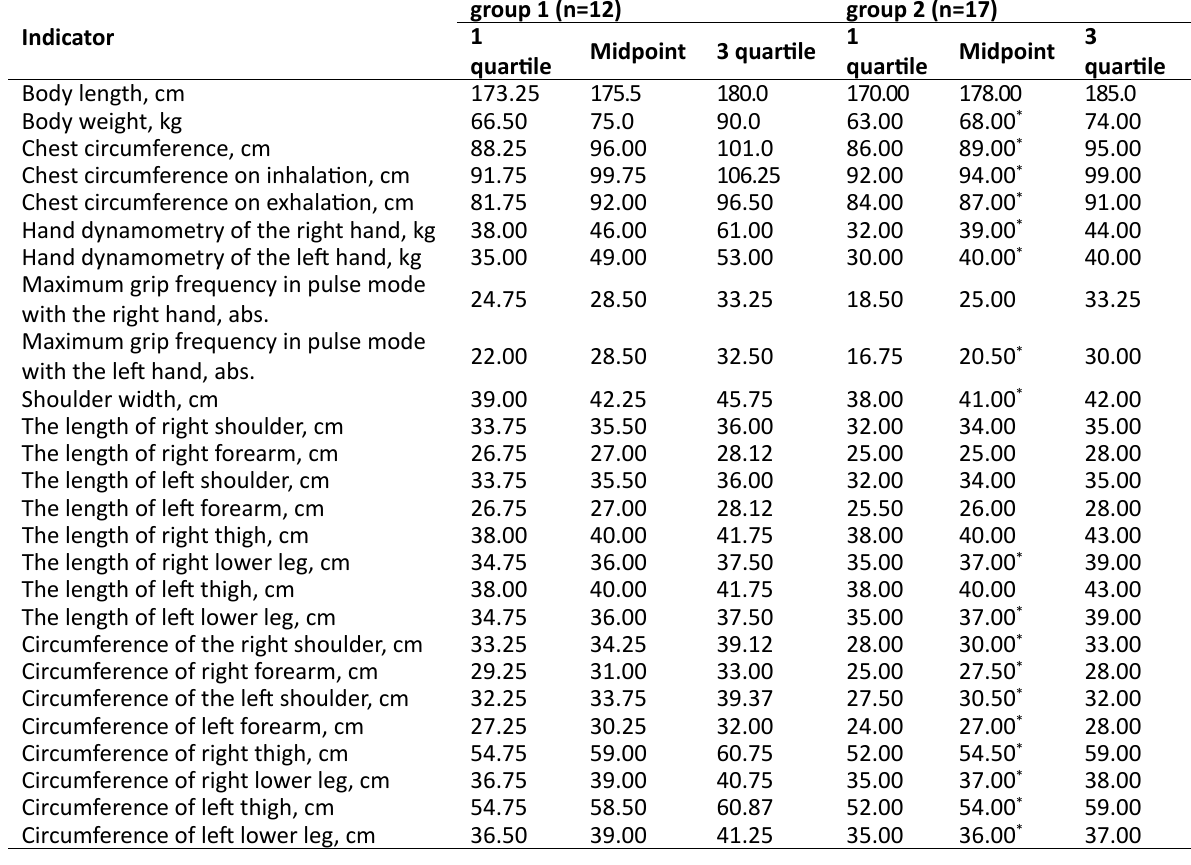
Table 1. Anthropometric indicators of single combats athletes Indicator